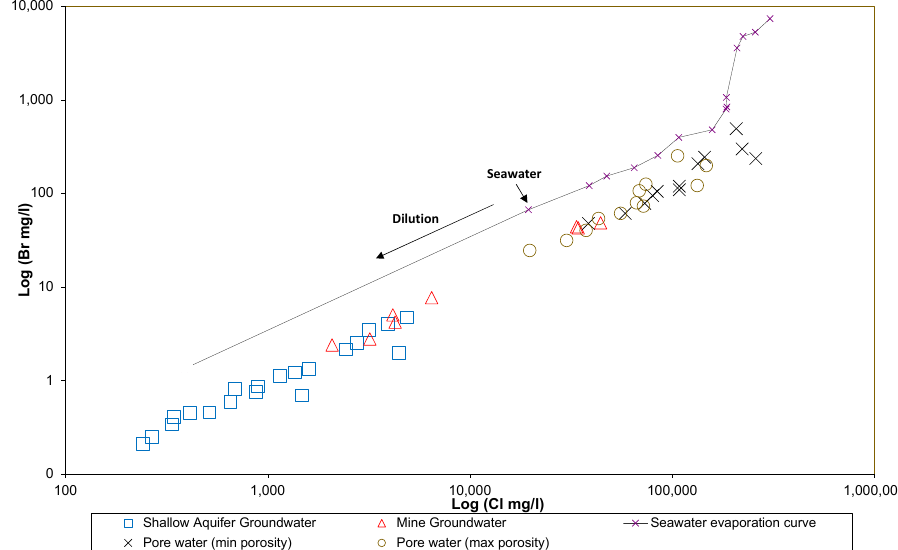
Figure 9. Log ‐ log plot of the calculated bromine and chloride of the poral water from leaching tests. In addition to the bromine and chloride of the shallow aquifer and mine groundwaters. Table 5. Contributions of meteoric water for mine water calculated from Cl − and Br − . Samples